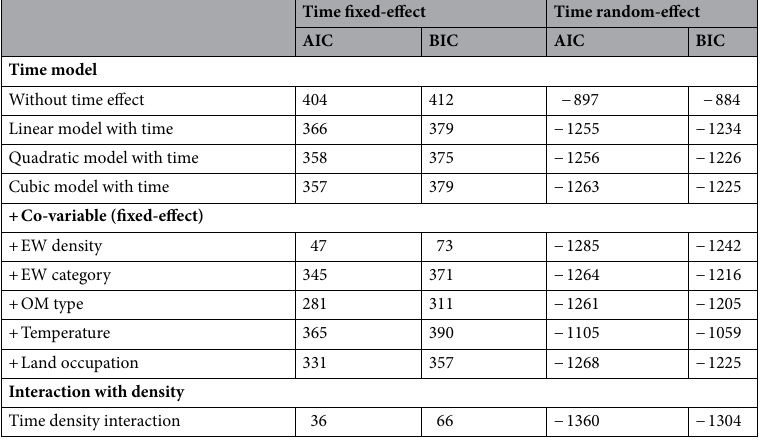
(with AIC of − 1285 versus AICs between − 1105 and − 1268 for the time random-effect model). Finally, the best model includes the interaction between the earthworm density and time (AIC of − 1360 for the random- temporal-effect model). Therefore, the cubic model including ‘time’ with random effects, ‘earthworm density’ with fixed effects, and their interaction (Table 2) better fit the observed data than the model including ‘time’ with fixed effects model (see Fig. 1). It can adapt the log ratio of the CO 2 emission curve shape to each experiment, while the fixed-effect model leads to a decreasing line that depends on the earthworm density. Additionally, this temporally random model has p values lower than 0.05, while the fixed-effect model has p values sometimes greater than 0.05 (Table 2). We plotted the full dataset (Fig. 4) and the curve calculated with our model (equation given in Table 2) by taking the median EW density values (1.95 mg EW/g soil DM, etype = 48). The modelling curve passes through the experimental data. The curve first increases until day 60 with a maximum increase in carbon mineralization from the EW treatment of 22.8% compared to the control treatment; the curve then decreases until it becomes negative at day 350. The estimated impact of earthworms on mineralization ranges from 20% (at day 60) and − 11% (at day 350) if the model uses the worm density of 0.5 mg/g soil DM commonly found in real conditions in the literature 11,12 .